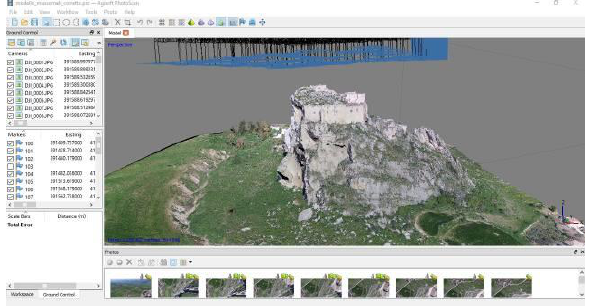
Figure 4. The 3D model of the castle obtained from the photogrammetric reconstruction